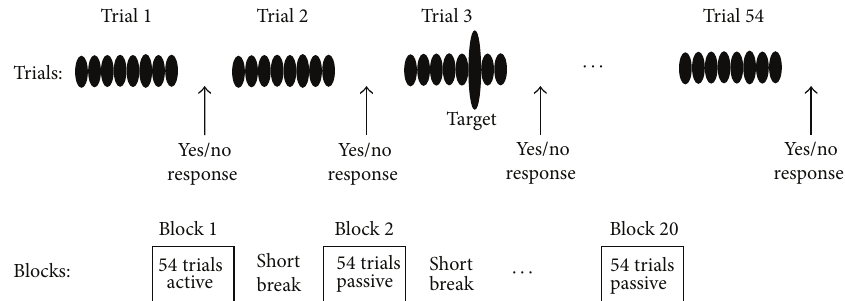
Figure 2: Auditory task. Upper panel: three standard 40Hz AM stimuli and one target stimulus containing a single amplitude-enhanced AM pulse (target) are illustrated by cartoons containing 8 AM pulses (40 pulses were delivered on each trial). Approximately 2/3rd of the stimuli contained a target of variable enhanced amplitude such that not all targets were detectable. Lower panel: on active blocks participants identified whether a target was present or not; on passive blocks participants ignored the sounds and waited for the next active block. Blocks contained 54 trials and alternated between active and passive blocks for a total of 20 blocks per